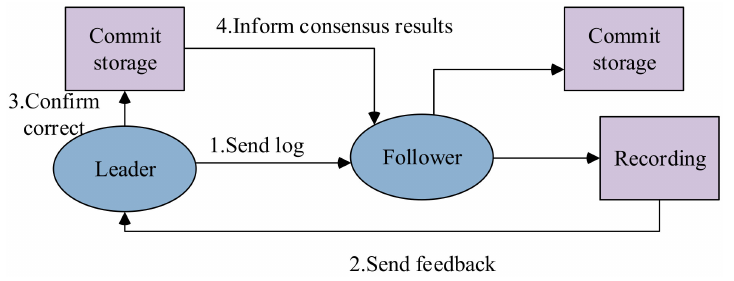
Figure 5. The process of Raft log